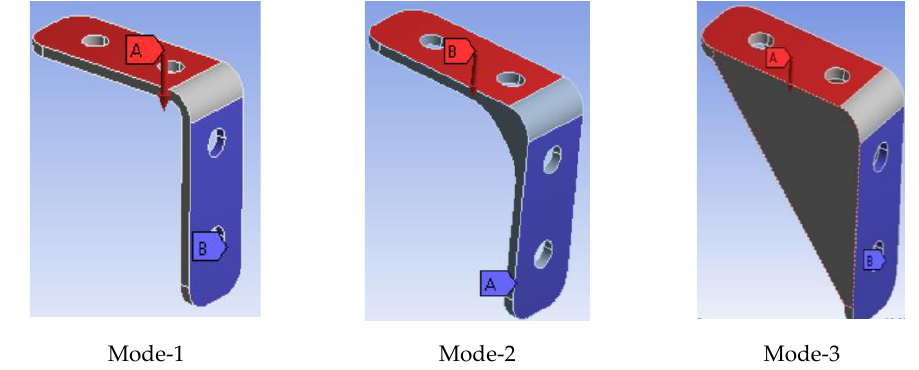
Figure 2. Shows the boundary conditions of all three models of the